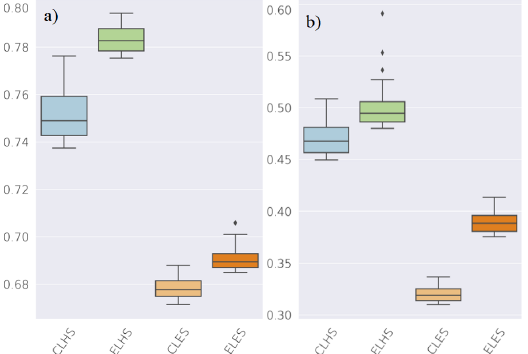
Figure A1. Boxplots of NSE value distribution of top 5% performing simulations during: ( a ) calibra- tion, ( b )